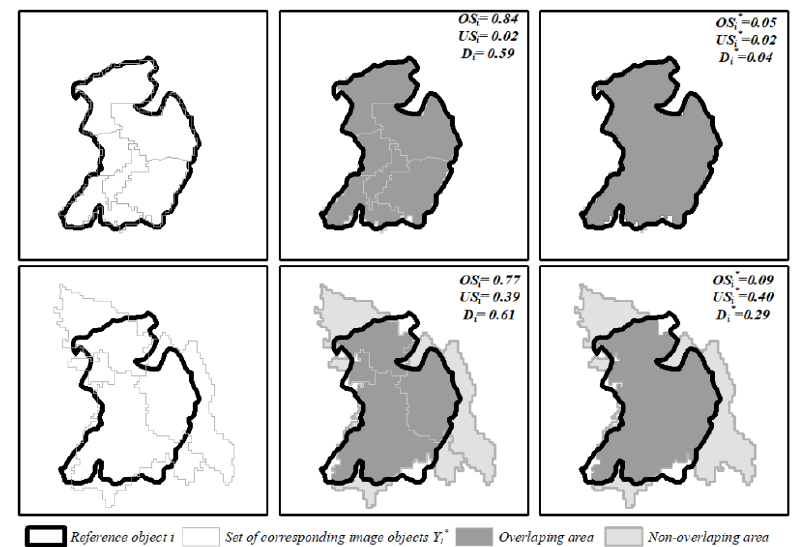
Figure 5. Illustration of the area-based dissimilarity metrics ( 𝑂𝑆 𝑖 , 𝑈𝑆 𝑖 , 𝐷 𝑖 ), and of the modified metrics ( 𝑂𝑆 𝑖∗ , 𝑈𝑆 𝑖∗ , 𝐷 𝑖∗ ). A reference object (black vectors) is displayed together with its corresponding set of image objects (gray vectors): The top row shows an example where the reference object is oversegmented, but not undersegmented (i.e., it is closely matched by the union area ⋃ 𝑦 𝑗𝑦 𝑗 ∈𝑌 𝑖∗ ); the bottom row shows an example where the reference object is both oversegmented, and undersegmented. The center column illustrates the traditional oversegmentation ( 𝑂𝑆 𝑖 ), undersegmentation ( 𝑈𝑆 𝑖 ) and summary score (𝐷 𝑖 ) for that single reference object, metrics that consider each individual corresponding image object. The right column illustrates the modified 𝑂𝑆 𝑖∗ , 𝑈𝑆 𝑖∗ , and 𝐷 𝑖∗ metrics, that consider instead the union area of all corresponding image objects. The summary score D does not report a significant difference between the two classifications (top: 𝐷 𝑖 = 0.59, bottom: 𝐷 𝑖 = 0.61), whereas the modified summary score D* indicates that through post-processing the top row segmentation could result in a near-perfect match with the reference object ( 𝐷 𝑖∗ = 0.04) but significant errors will remain in the bottom row segmentation ( 𝐷 𝑖∗ = 0.29).